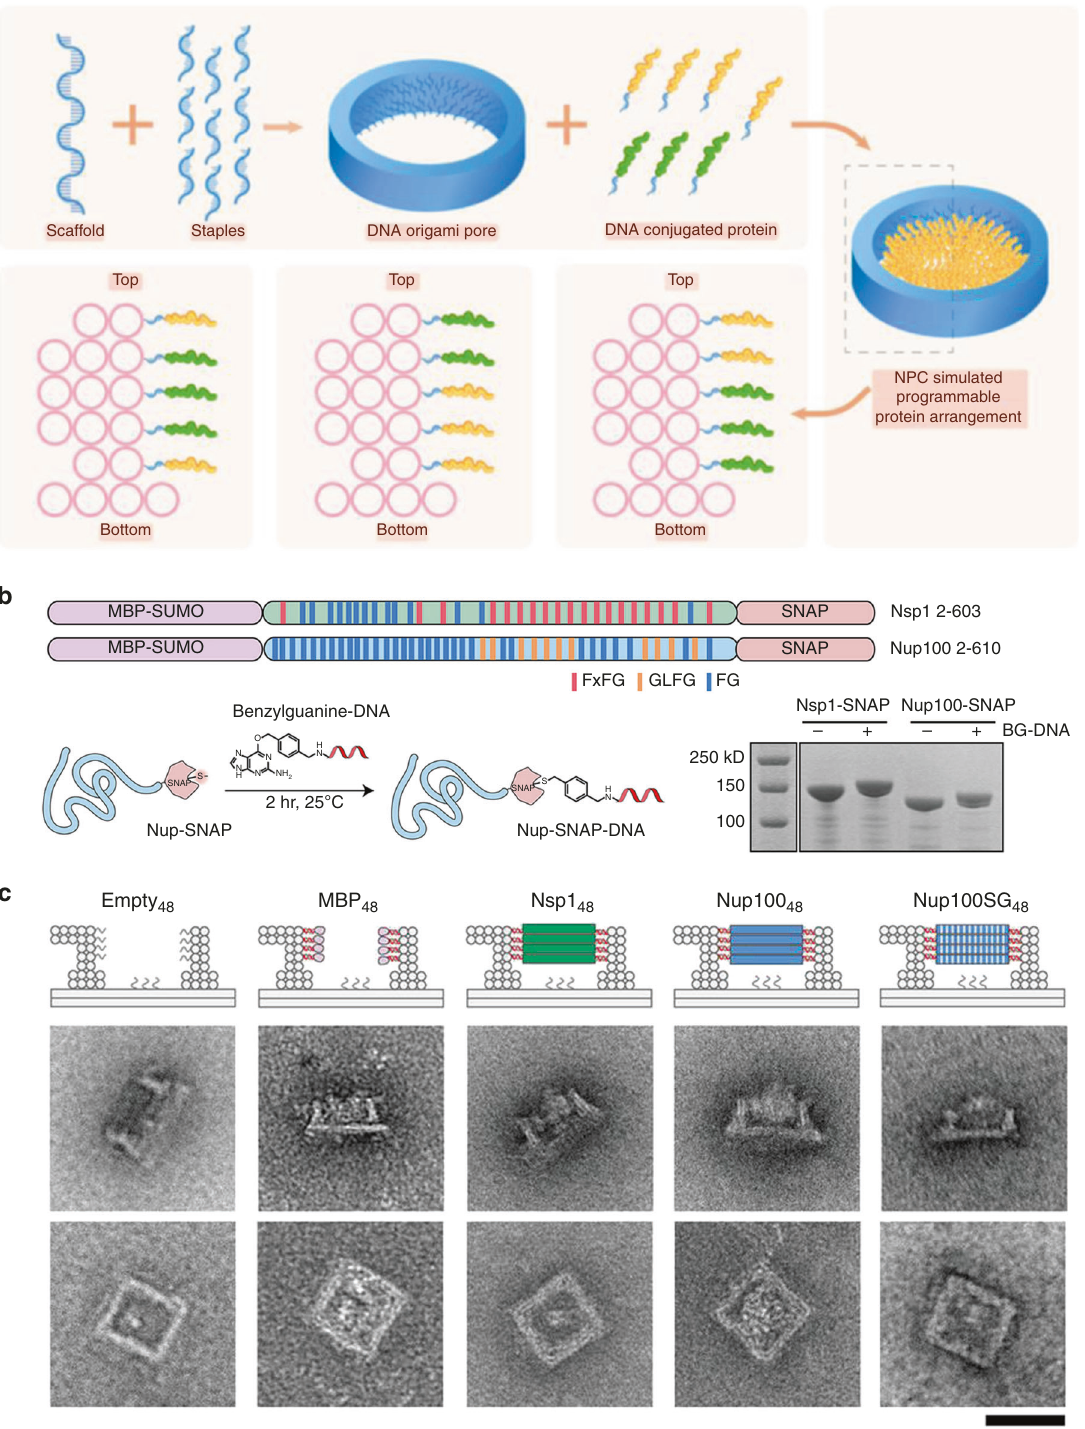
Fig. 5 Assembly of nuclear pore complex mimics by DNA origami. a Schematic illustration of the fabrication of the DNA origami NPC mimic and its application in programmable protein arrangement. b As reported by Qi et al. 34 two central channel nucleoporins of yeast origin, Nsp1 and Nup100, were expressed with a SNAP tag, which enables their conjugation with a benzylguanine-modi fi ed DNA oligo. c Illustration and TEM images of different protein-gated DNA origami NPC mimics. Scale bar = 50 nm. Copyright 2021, American Chemical